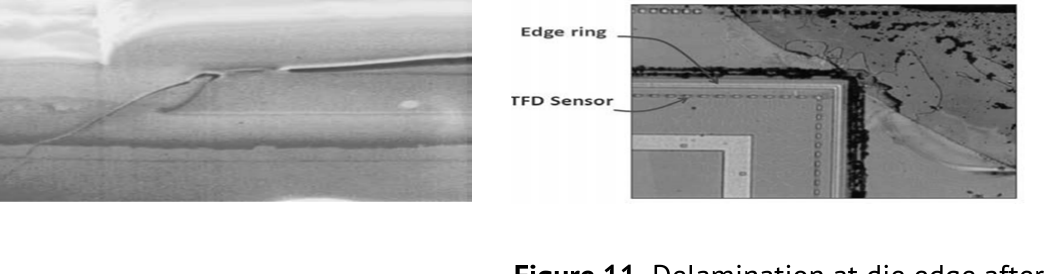
Figure 10. Thin film cracking TFC